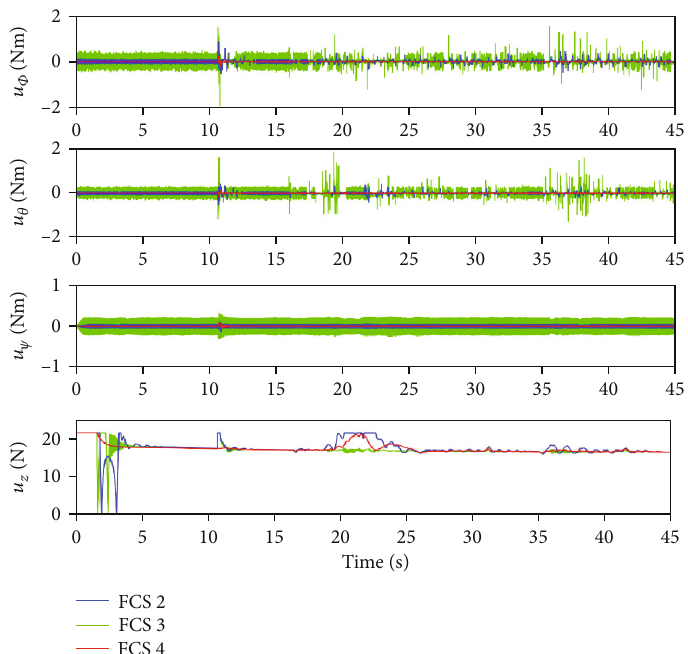
Figure 11: Control signals, i.e., ð u , u Φ , u θ , u ψ Þ , of the proposed FCS 4, FCS 2, and FCS3. The control signals of the proposed FCS 4 are z chattering-free: fl ight scenario 1.